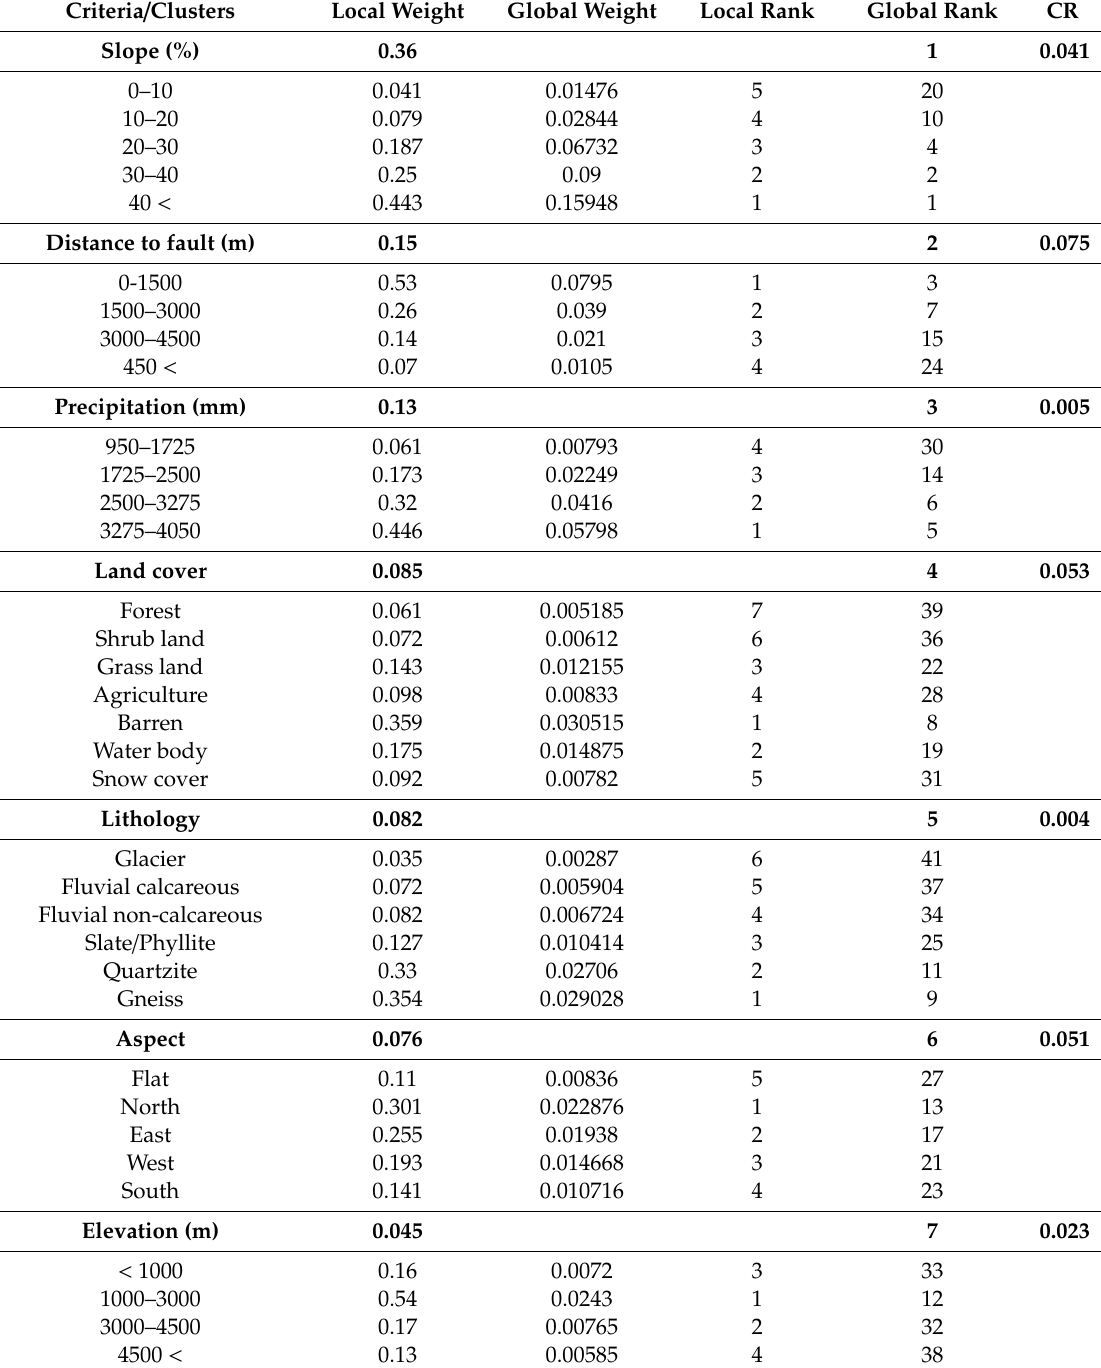
Table 5. Fuzzy best-worst multi-criteria decision-making (FBWM) model